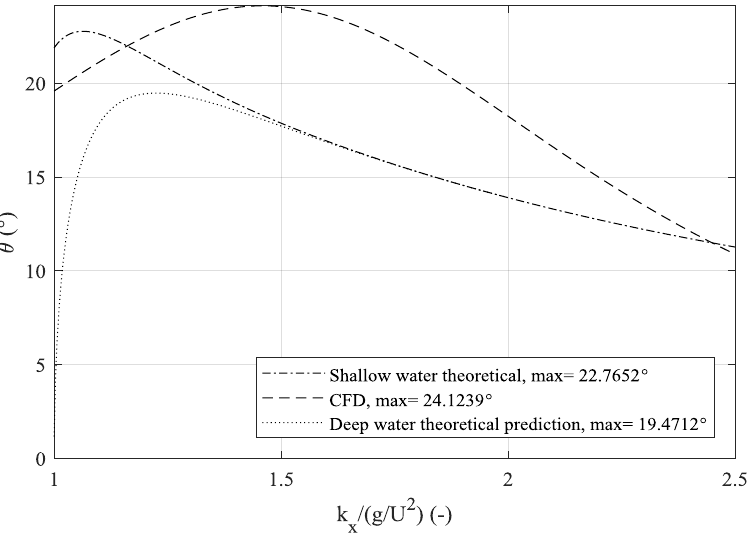
Figure 13. Predicted and theoretical half-angles.